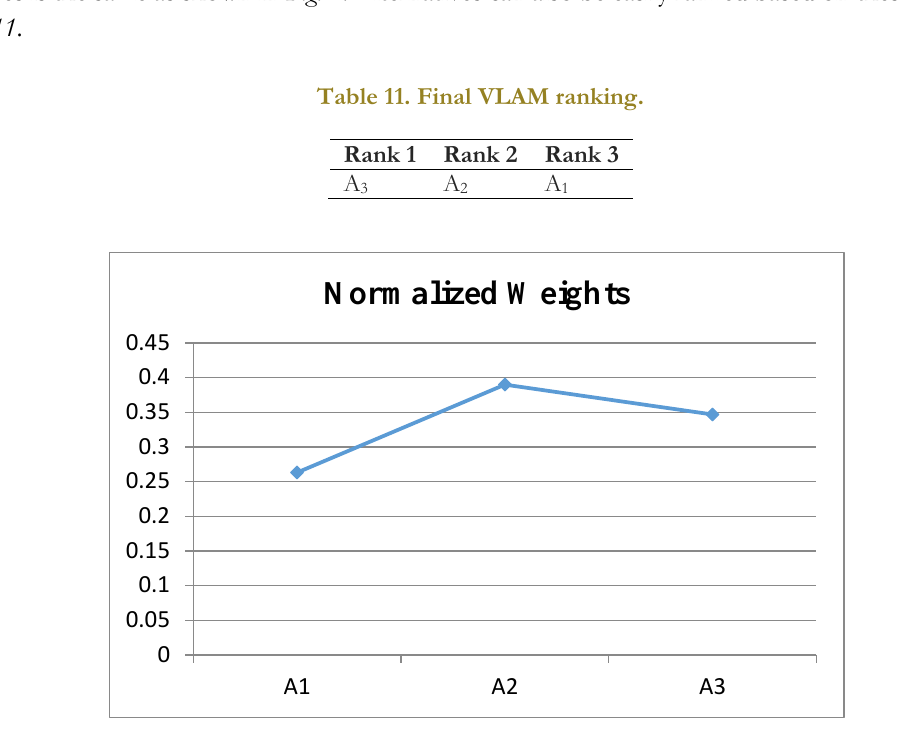
Fig. 2. Final VLAM results by ε=ε *